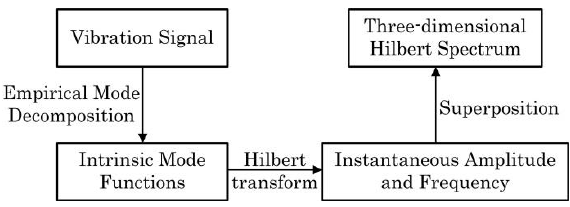
Figure 6. Flow chart of HHT.